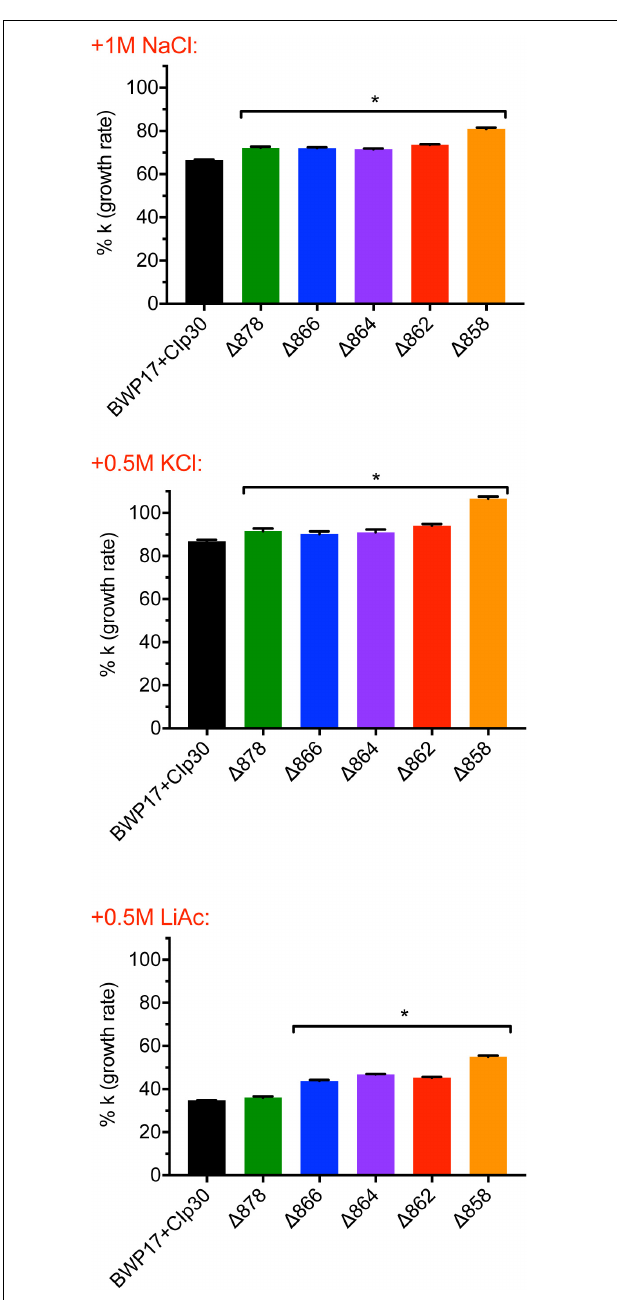
FIGURE 3 | Growth of Pma1p truncation mutants in the presence of cations. Growth was measured in Pma1p truncation mutants by growing cells in complete synthetic media with 2% glucose ± 1M NaCl, 0.5M KCl or 0.5M LiOAc (lithium acetate) in a plate reader with optical density at 600 nm (OD 600 ) readings taken at 15 min intervals. Growth rate (k) was calculated using Graphpad Prism software, and %k was calculated for each strain by comparing growth in the presence of salts to growth in media without salts added. Increasing Pma1p truncation decreases the effect of cation addition on growth. Each graph represents a single representative experiment; experiments were completed twice. Growth rates were analyzed for statistical differences compared to growth of the BWP17+CIp30 control in the presence of each salt via two-way ANOVA followed by a multiple comparison post-test. Asterisks denote statistical significance ( p >